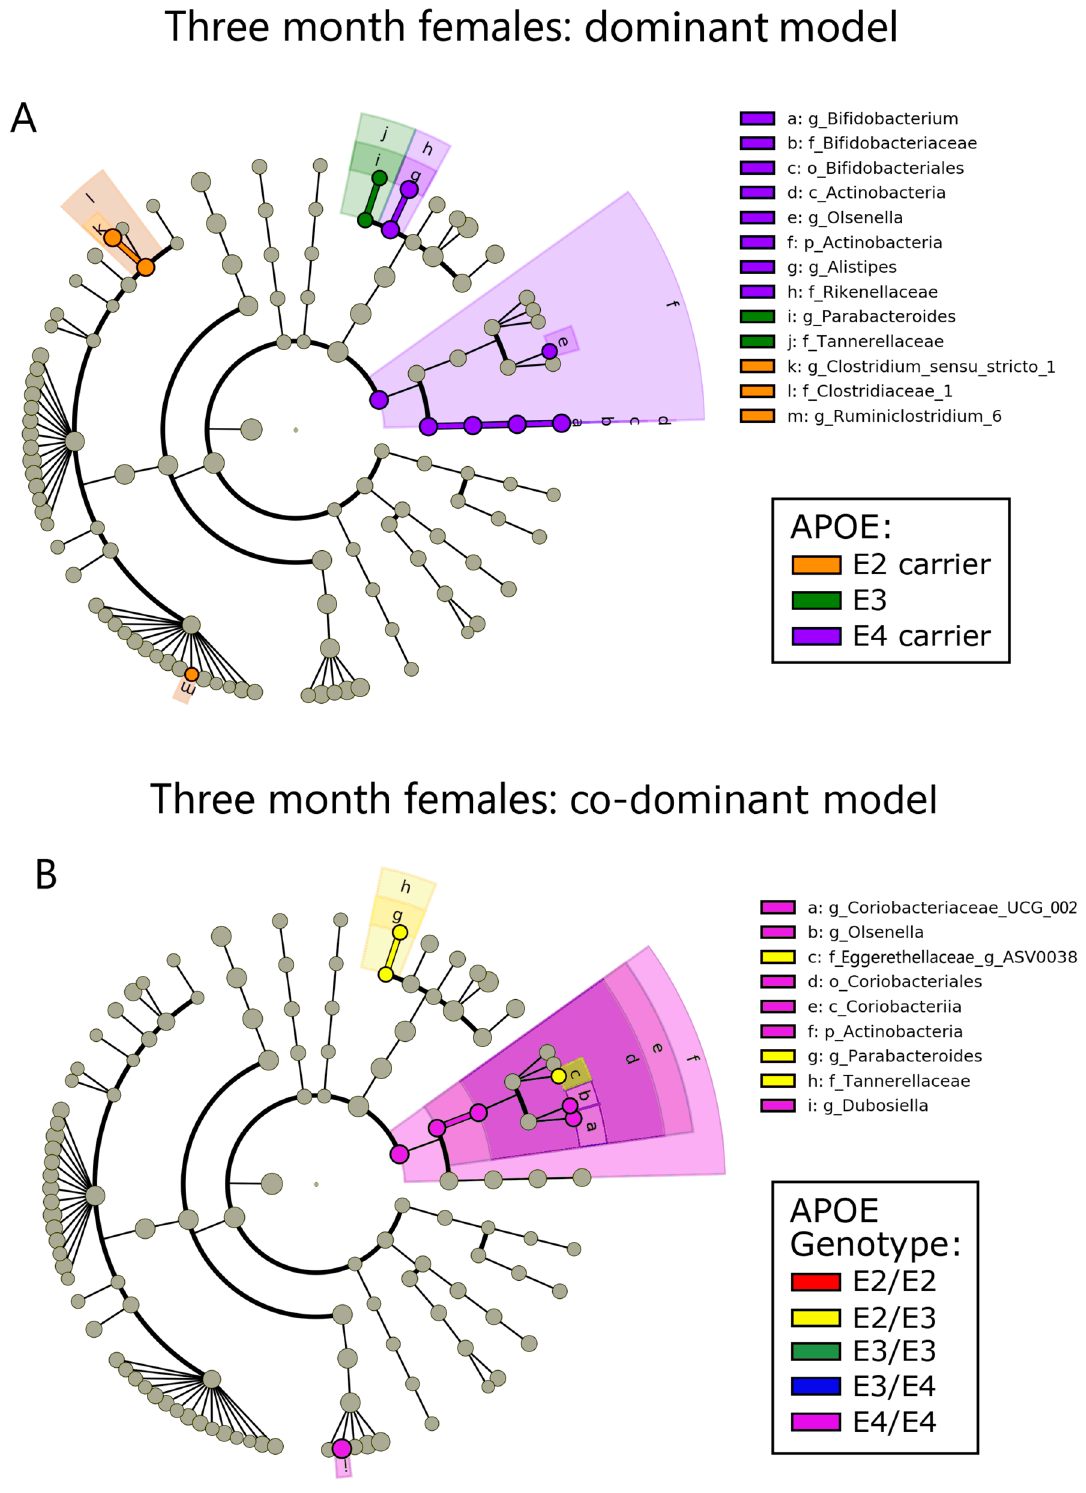
Figure 2. Cladograms reveal microbial phylogenetic branches associated with APOE status in females. Taxa significantly associated with APOE are highlighted (p < 0.05 for Kruskal–Wallis tests and a logarithmic LDA score >